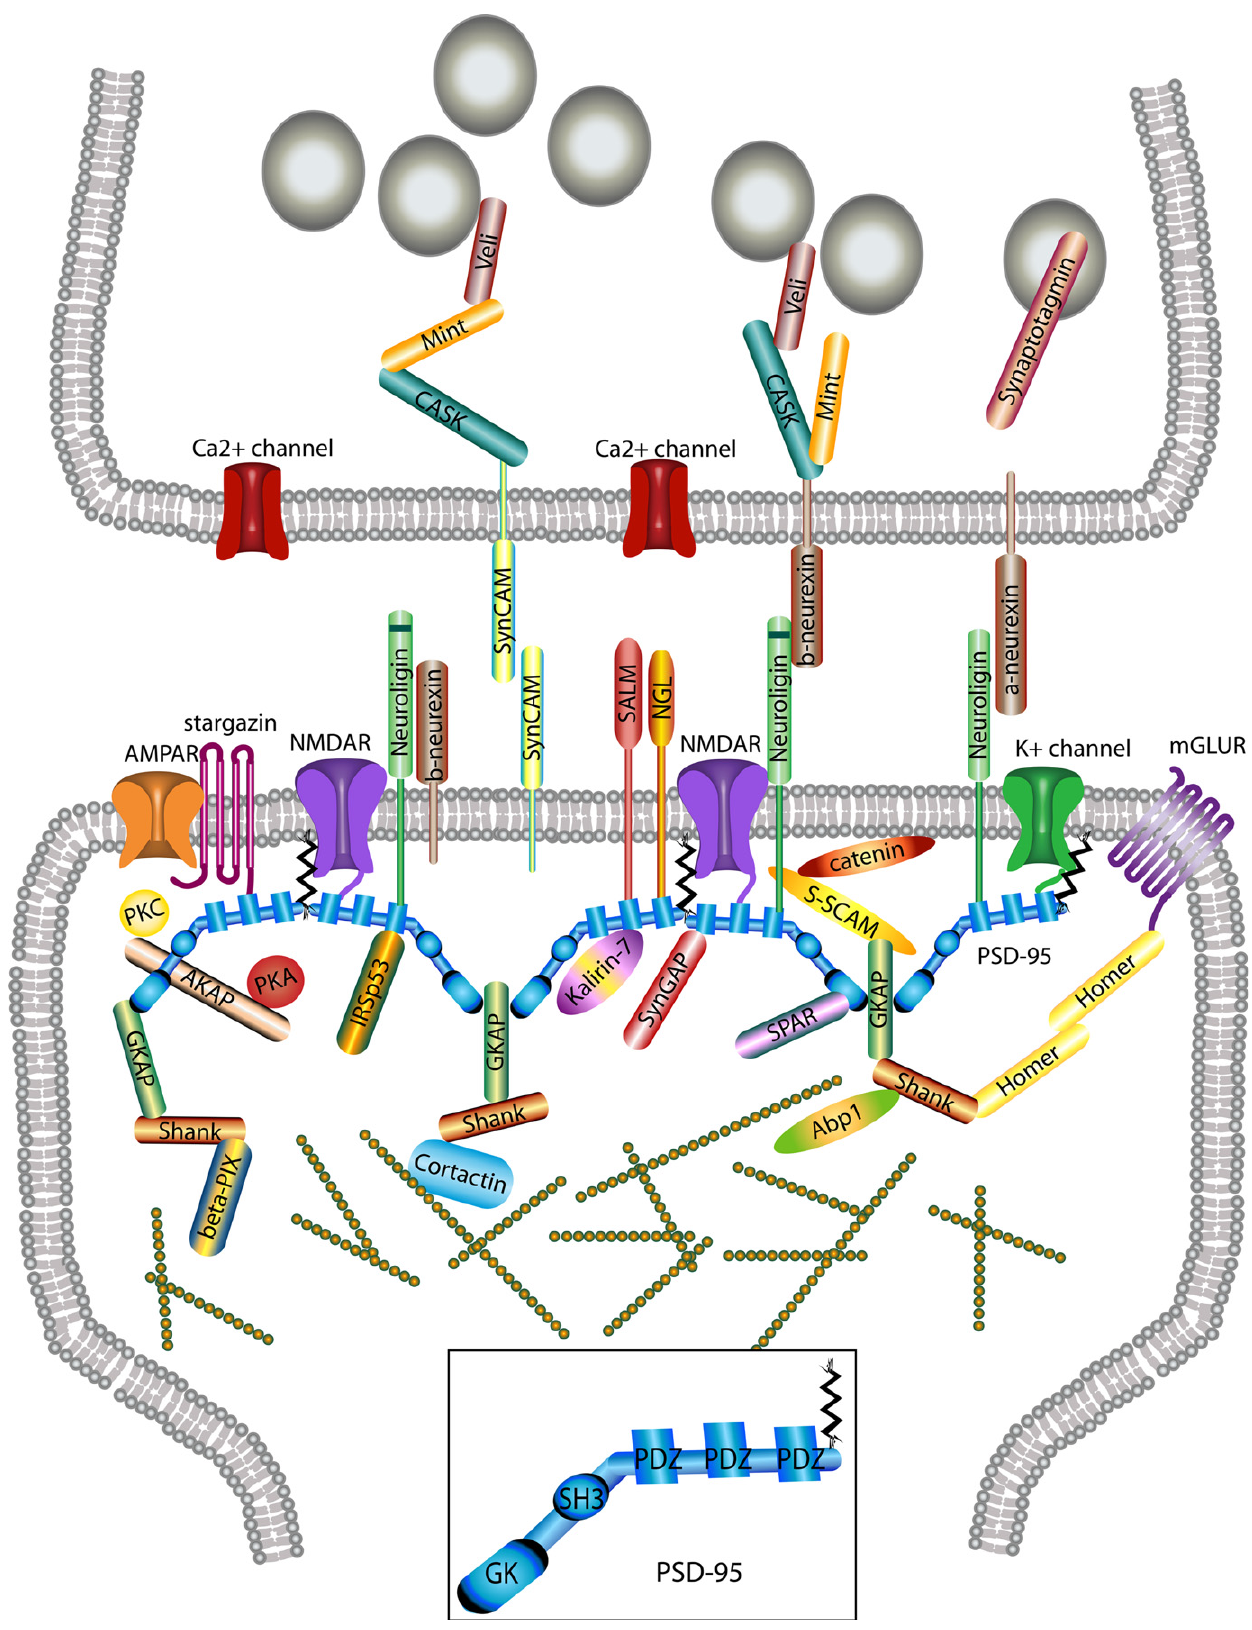
Figure 2. Macromolecular PSD-95 complex. The molecular organization of glutamatergic synapses is presented, but only major molecules associated with PSD-95 are shown. The various molecules portrayed regulate synapse function, morphology, traffi cking and localization of adhesion molecules and neuro- transmitter